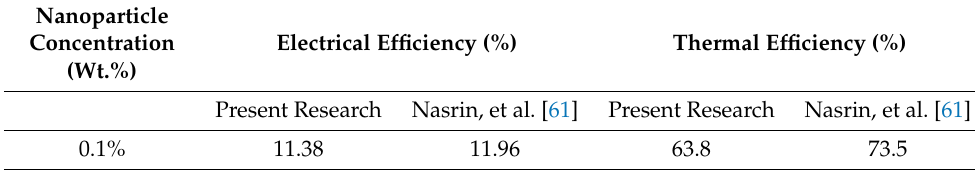
Table 7. Validation of Electrical and thermal efficiency.